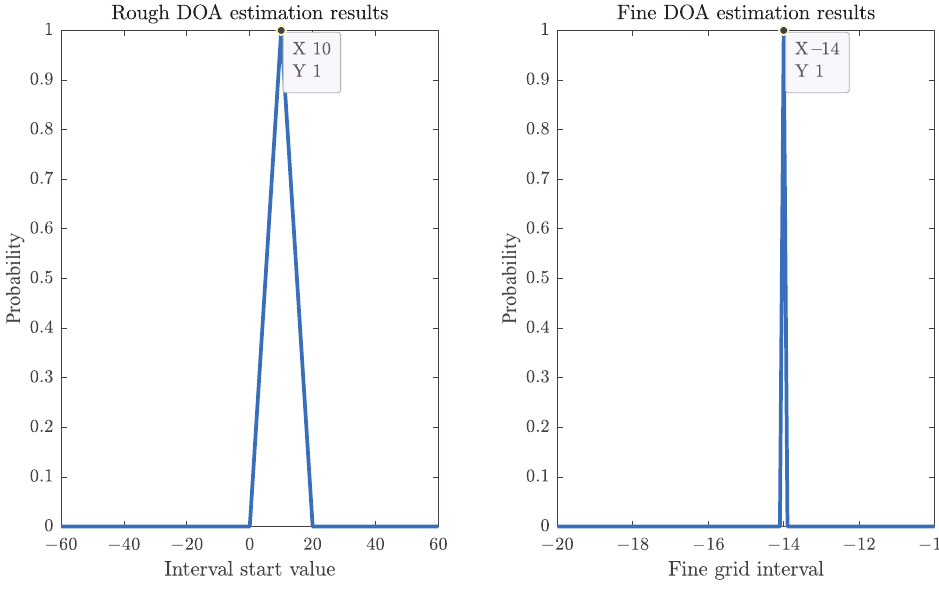
Figure 7. DOA estimation